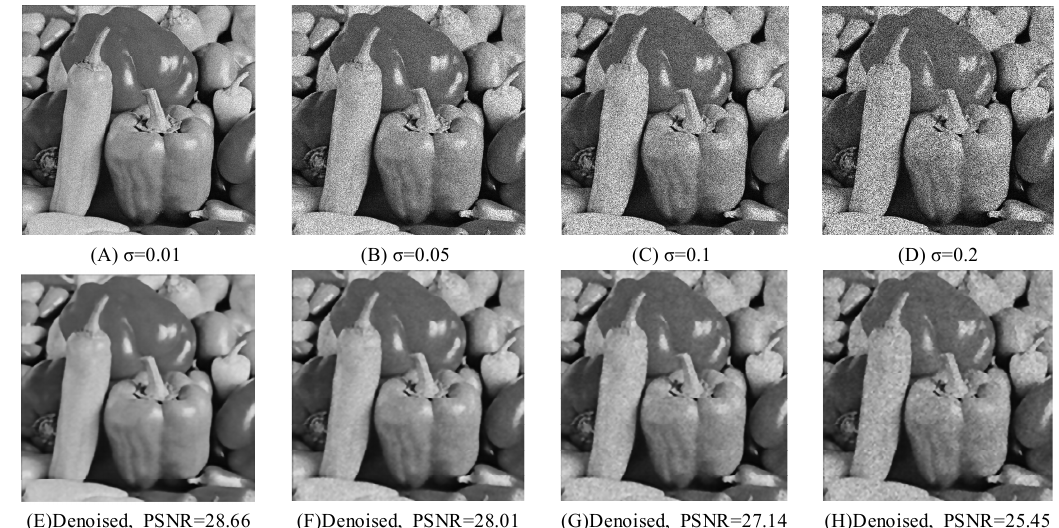
Figure 19. Denoising results of Peppers with Speckle noise using IFOA ‐ DTCWT ‐ BF. (A) Peppers of noise σ = 0.01; (B) Peppers of noise σ = 0.05; (C) Peppers of noise σ = 0.1; (D) Peppers of noise σ = 0.2; (E) Denoised image of σ = 0.01; (F) Denoised image of σ = 0.05; (G) Denoised image of σ = 0.1; (H) Denoised image of σ = 0.2.